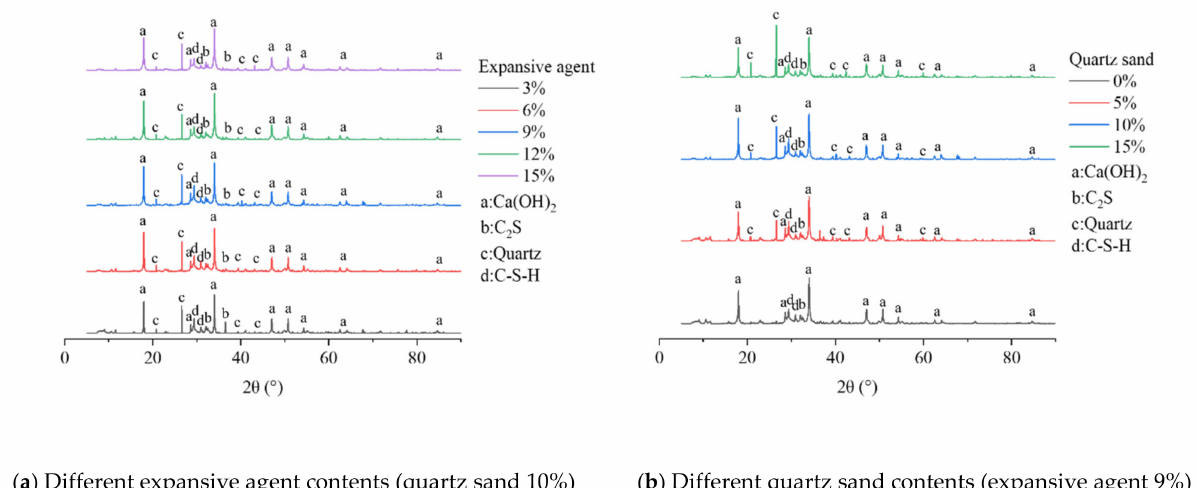
Figure 4. XRD patterns of expansive grout samples.